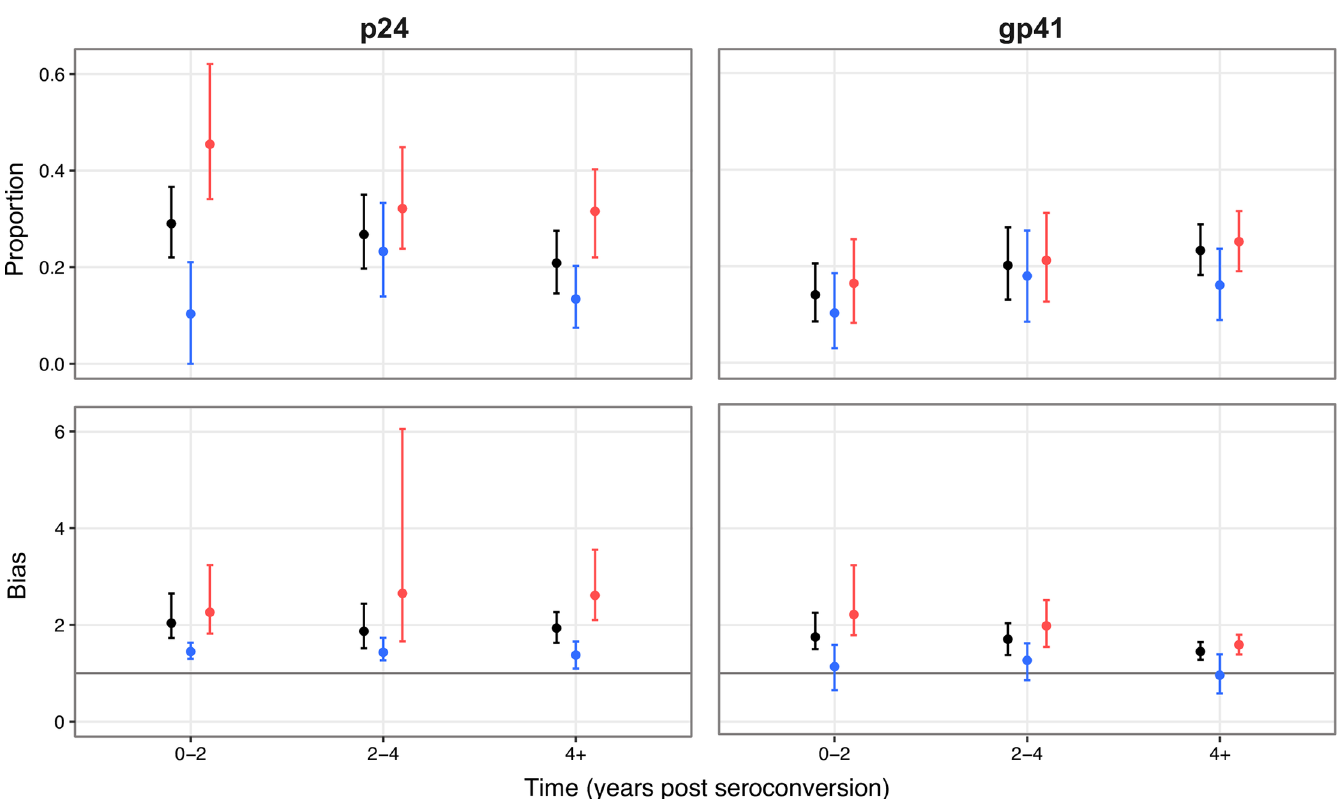
Fig 3. Changes towards population consensus. Top Row: The proportion of polymorphic sites where a mutant allele represents a change towards the (subtype-specific) population consensus. Bottom Row: The bias in changes towards population consensus. This is the ratio of the proportion of changes that are towards (subtype-specific) population consensus, compared to the expected proportion in the absence of selection, measured at polymorphic sites and with an assumed mutational transition to transversion ratio of two. A bias of 1 means the proportion of changes that are towards population consensus matches the expectation. The error bars give the 5 and 95 percentiles from 10,000 bootstraps of the individual data. Black, all changes; Blue, synonymous changes; Red, nonsynonymous